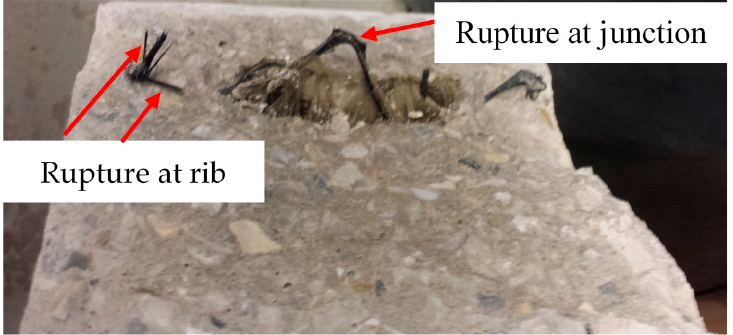
Figure 6. Rupture failure of geogrid.